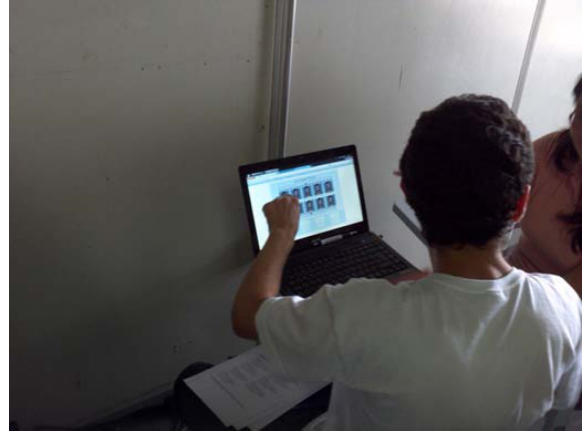
Figure 23 – Photos of the evaluation process (2)